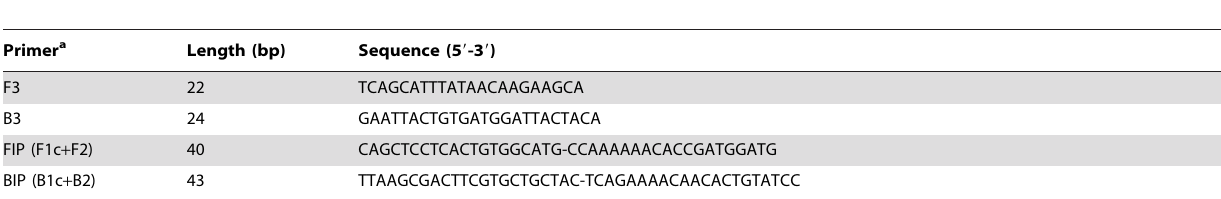
Table 1. Sequences of LAMP primers for the amplification of the repetitive DNA sequence from Loa loa (GenBank Accesion No. M34259.1).